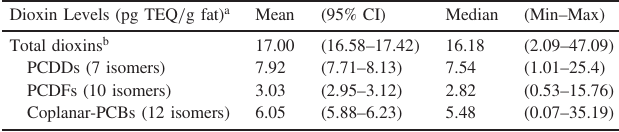
Table 2. Dioxin levels in human breast milk for all